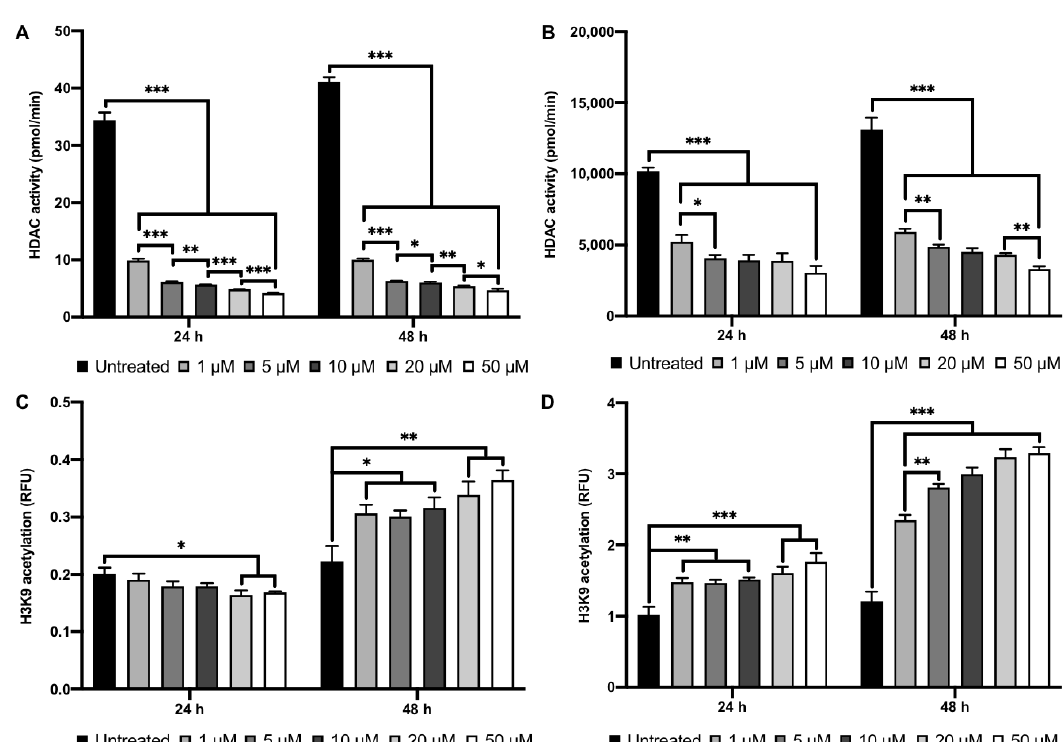
Figure 3. The influence of MI192 on hDPSCs epigenetic functionality. HDAC activity levels ( A ) immediately post MI192 treatment and ( B ) 1 week post MI192 treatment. H3K9 histone acetylation levels ( C ) immediately post MI192 treatment and ( D ) 1 week post MI192 treatment. Data are expressed as mean ± SD ( n = 3). * p ≤ 0.05, ** p ≤ 0.01 and *** p ≤ 0.001.